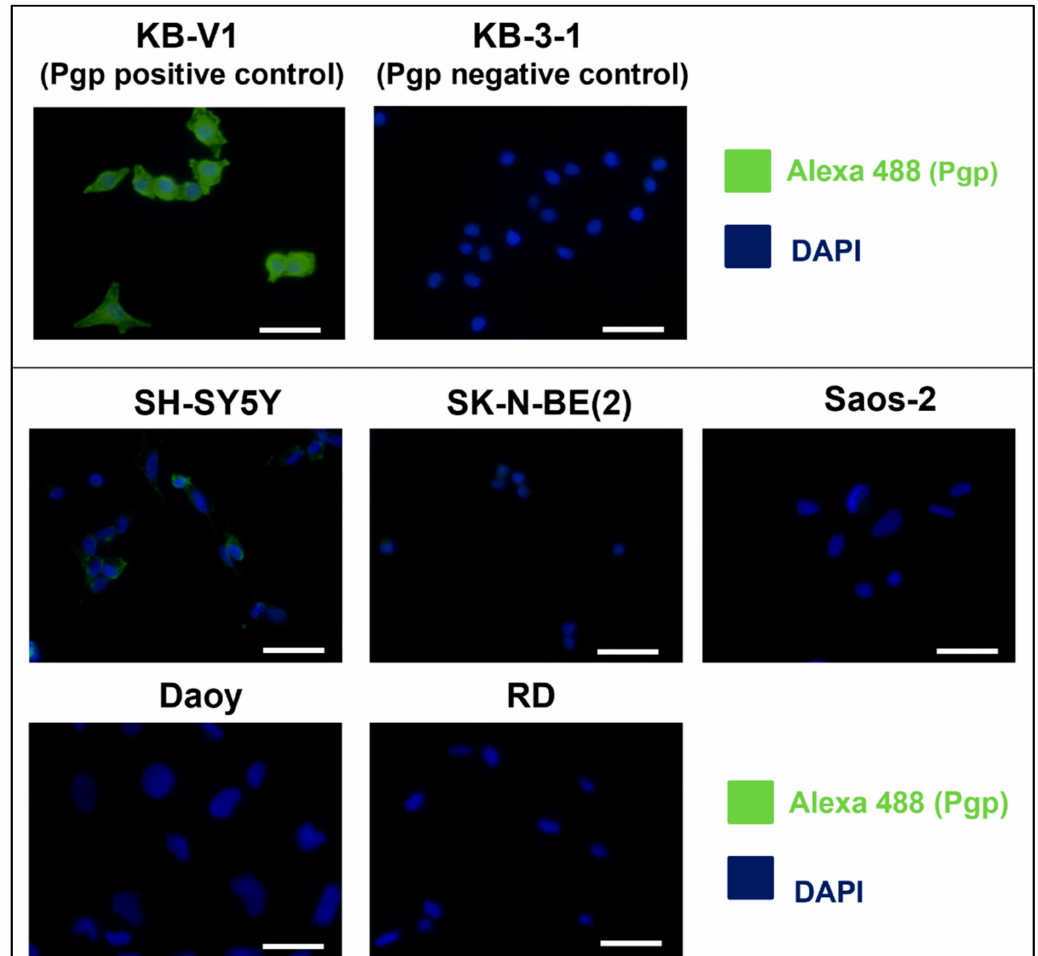
Figure 2. Pgp expression in the untreated cell lines. The expression of Pgp analyzed in the untreated cell lines was visualized by indirect immunofluorescence using an anti-Pgp primary antibody and an Alexa-488-conjugated secondary antibody (green signal). Nuclei were labeled by DAPI (blue signal). KB-V1 cells served as positive controls for Pgp expression, whereas KB-3-1 cells served as negative controls. The scale bars represent 50 µ m.